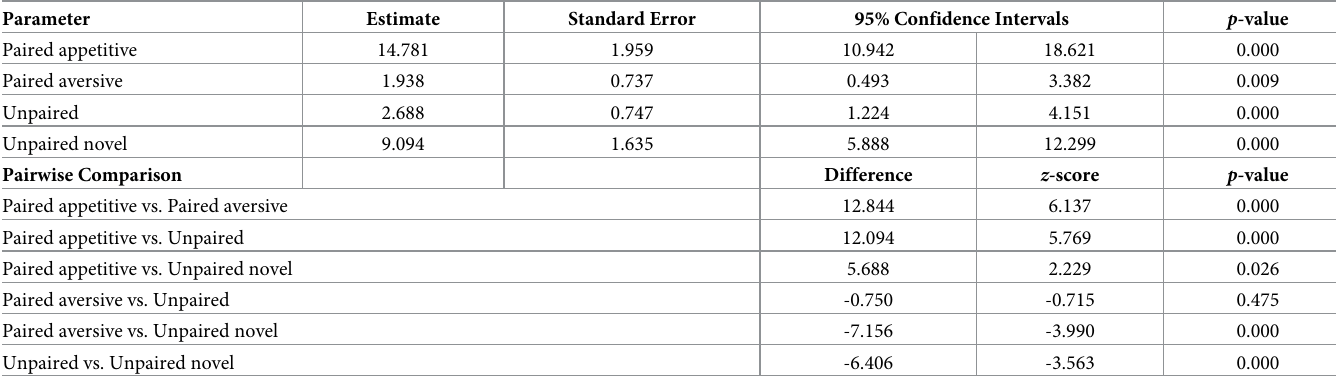
Table 5. Experiment 1 preference MPR duration.